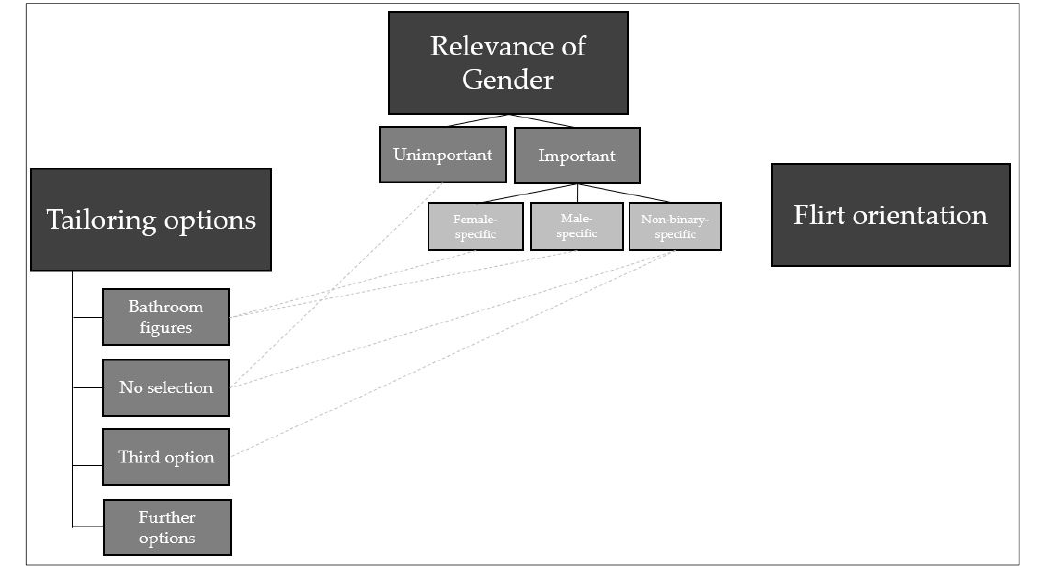
Figure 1. Overview of the final thematic map.